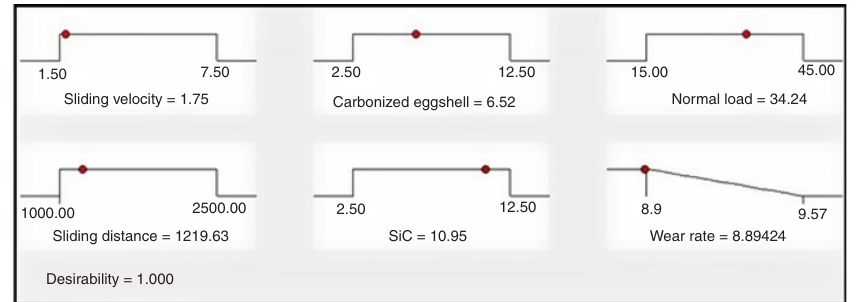
Figure 13: Interaction of sliding distance with SiC wt.% to reduce wear rate.